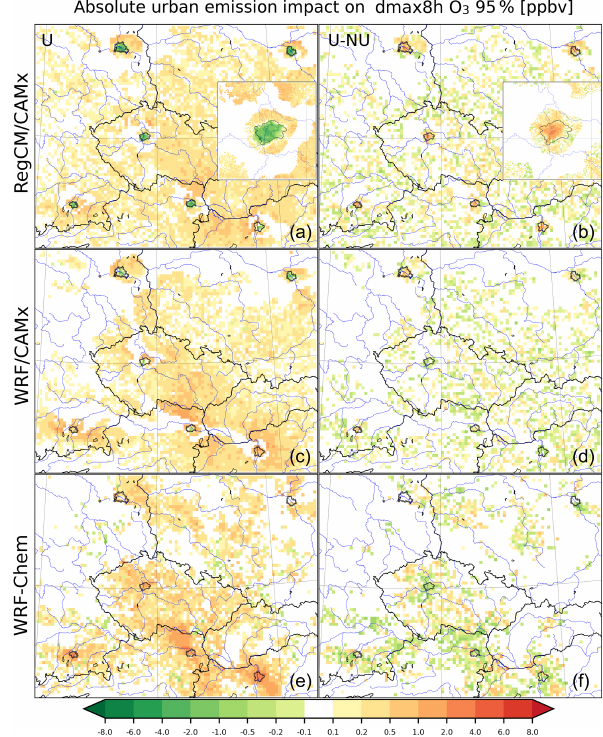
Figure 14. Same as Fig. 12 but for the maximum daily 8h O 3 in parts per billion volume